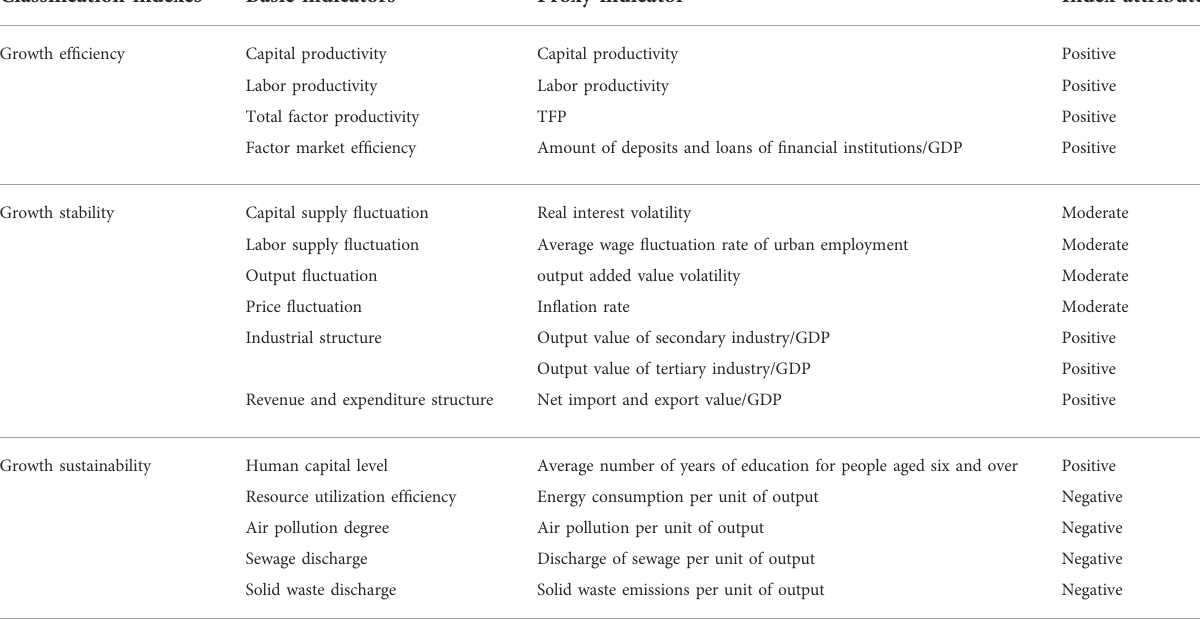
TABLE 2 Comprehensive evaluation index system of economic growth quality.